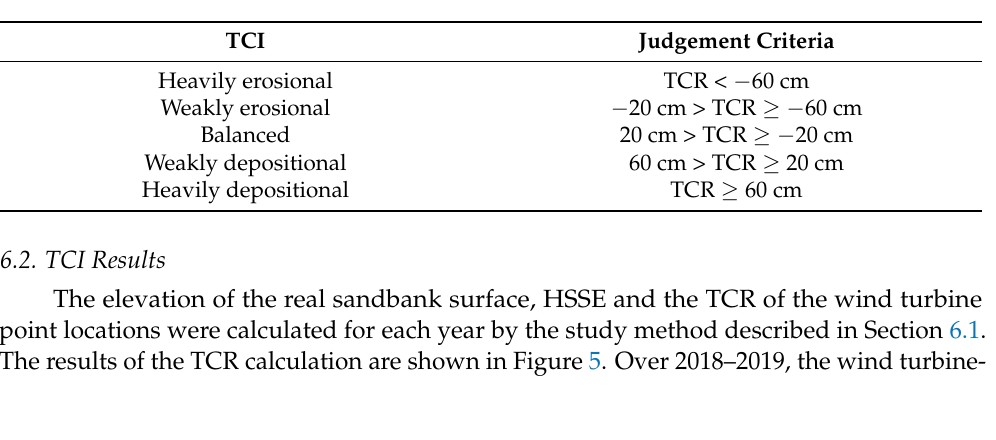
Table 1. Wind turbine-caused TCI determination